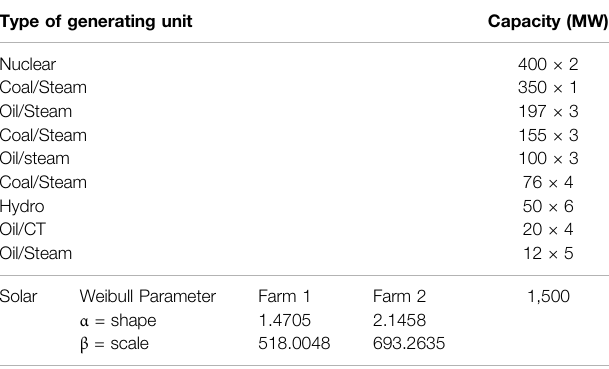
TABLE 4 | Type of generator with their capacities connected in modi fi ed